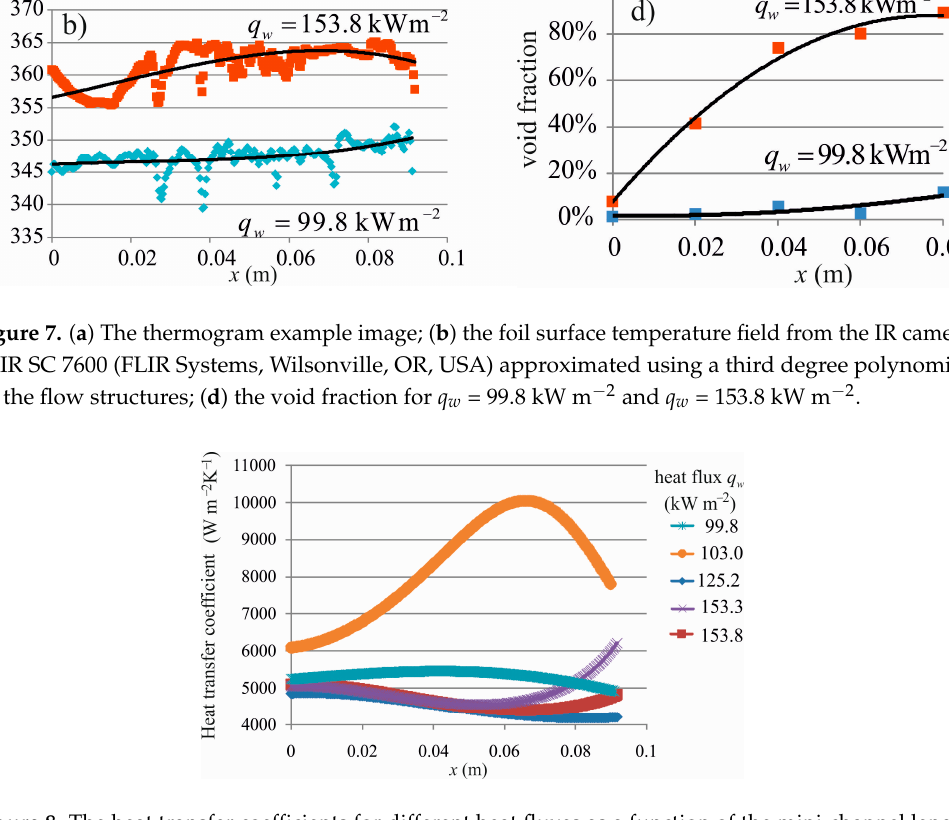
Figure 8. The heat transfer coefficients for different heat fluxes as a function of the mini-channel length obtained using the hybrid Picard–Trefftz method.